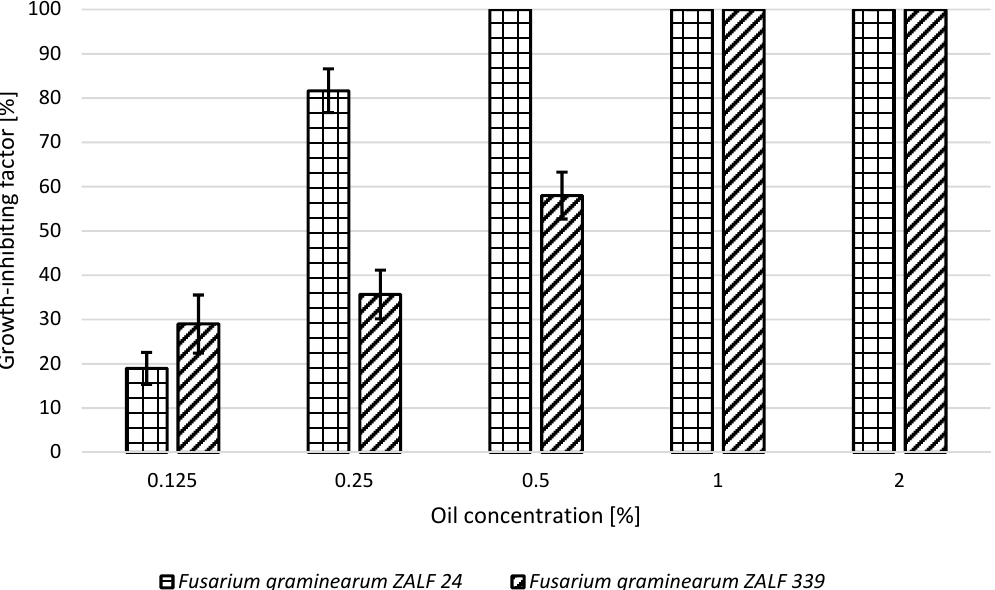
Figure 1. Growth-inhibiting factor of Fusarium graminearum ZALF 24 and Fusarium graminearum ZALF 339 strains in the presence of lemon oil.